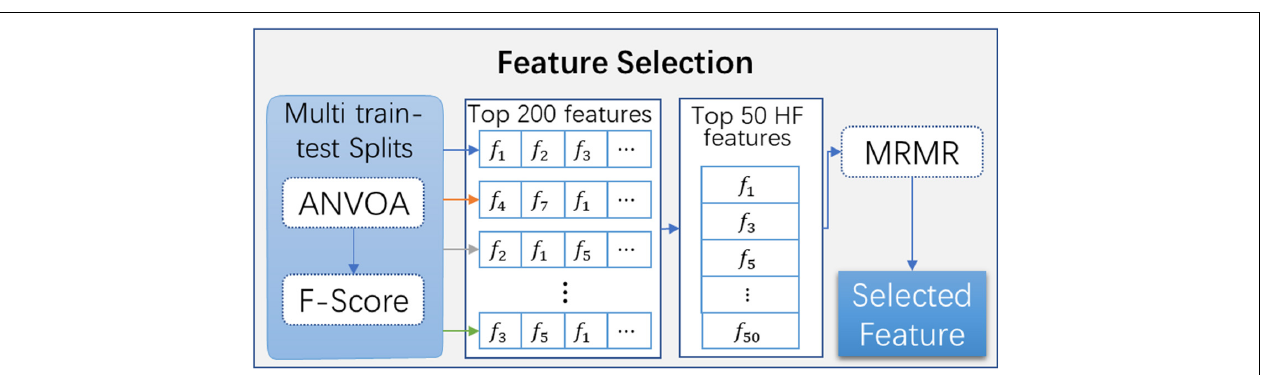
FIGURE 2 | (A) The procedure of prediction model construction. (B) The procedure of classification model construction.